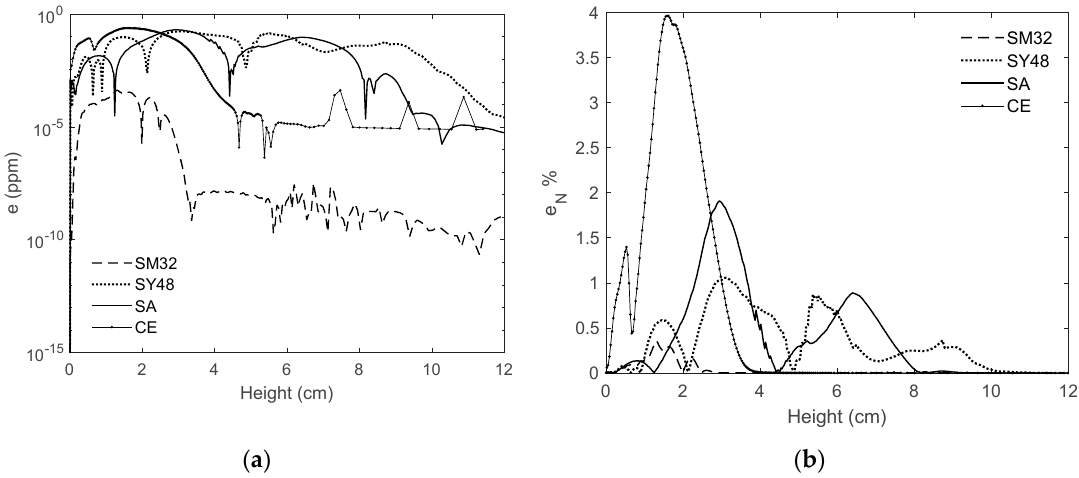
Figure 16. The variations of average error versus height: ( a ) absolute error; ( b ) absolute error normalized with the peak soot volume fraction.